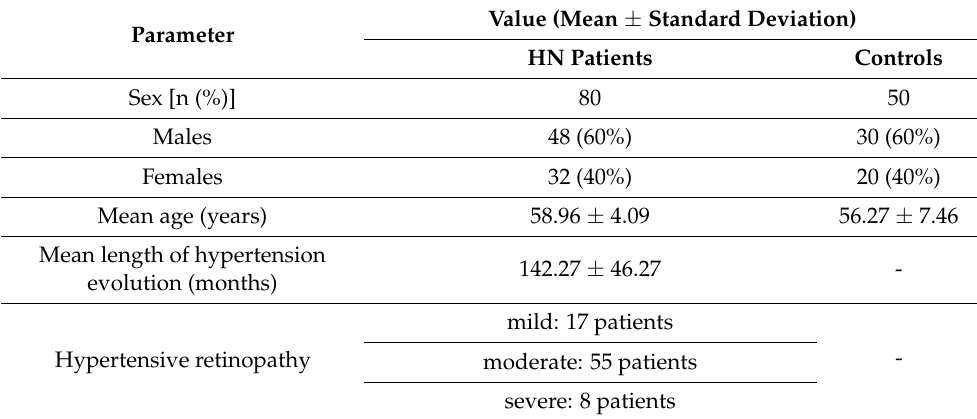
Table 1. Baseline participant